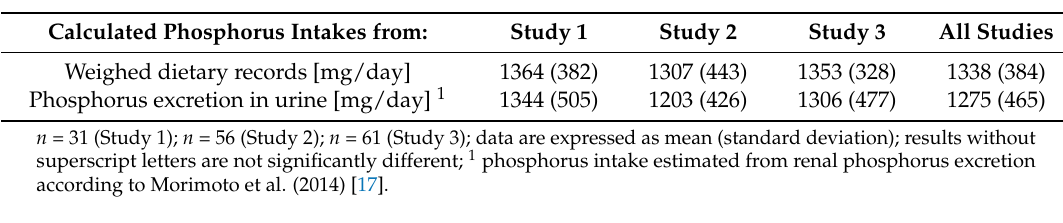
Table 6. Comparison of phosphorus intake calculated from weighed dietary records with estimations of phosphorus intake from renal phosphorus